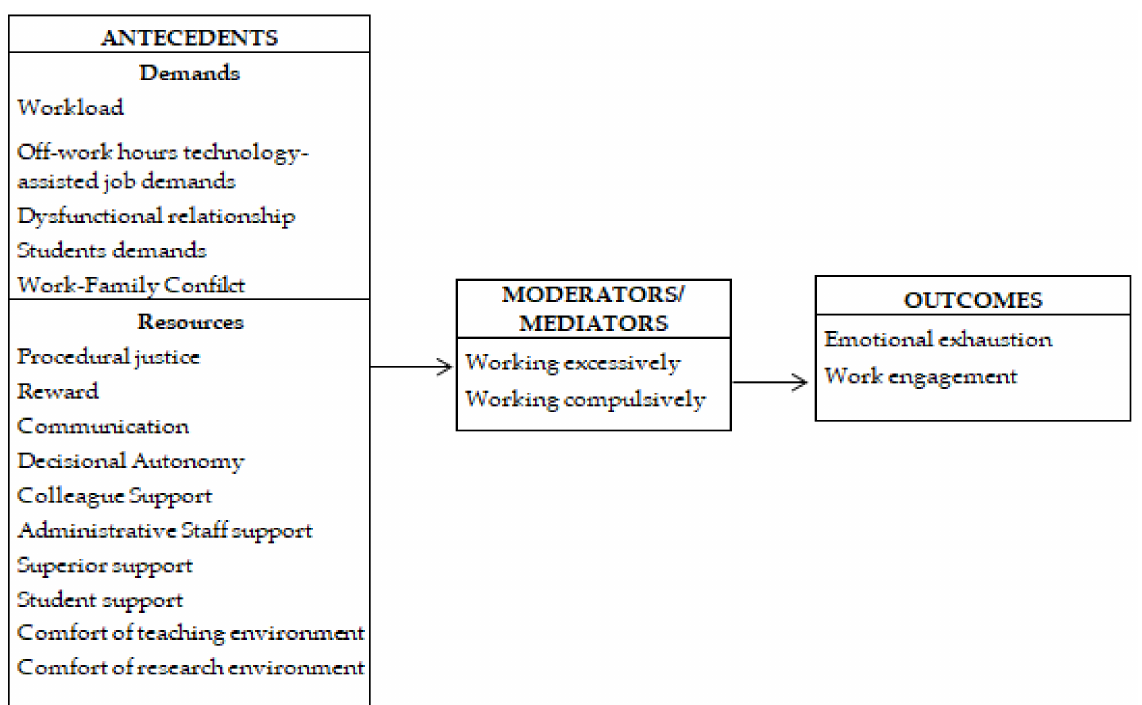
Figure 2. Set of variables composed of demands, resources, mediators, and outcomes included in Study